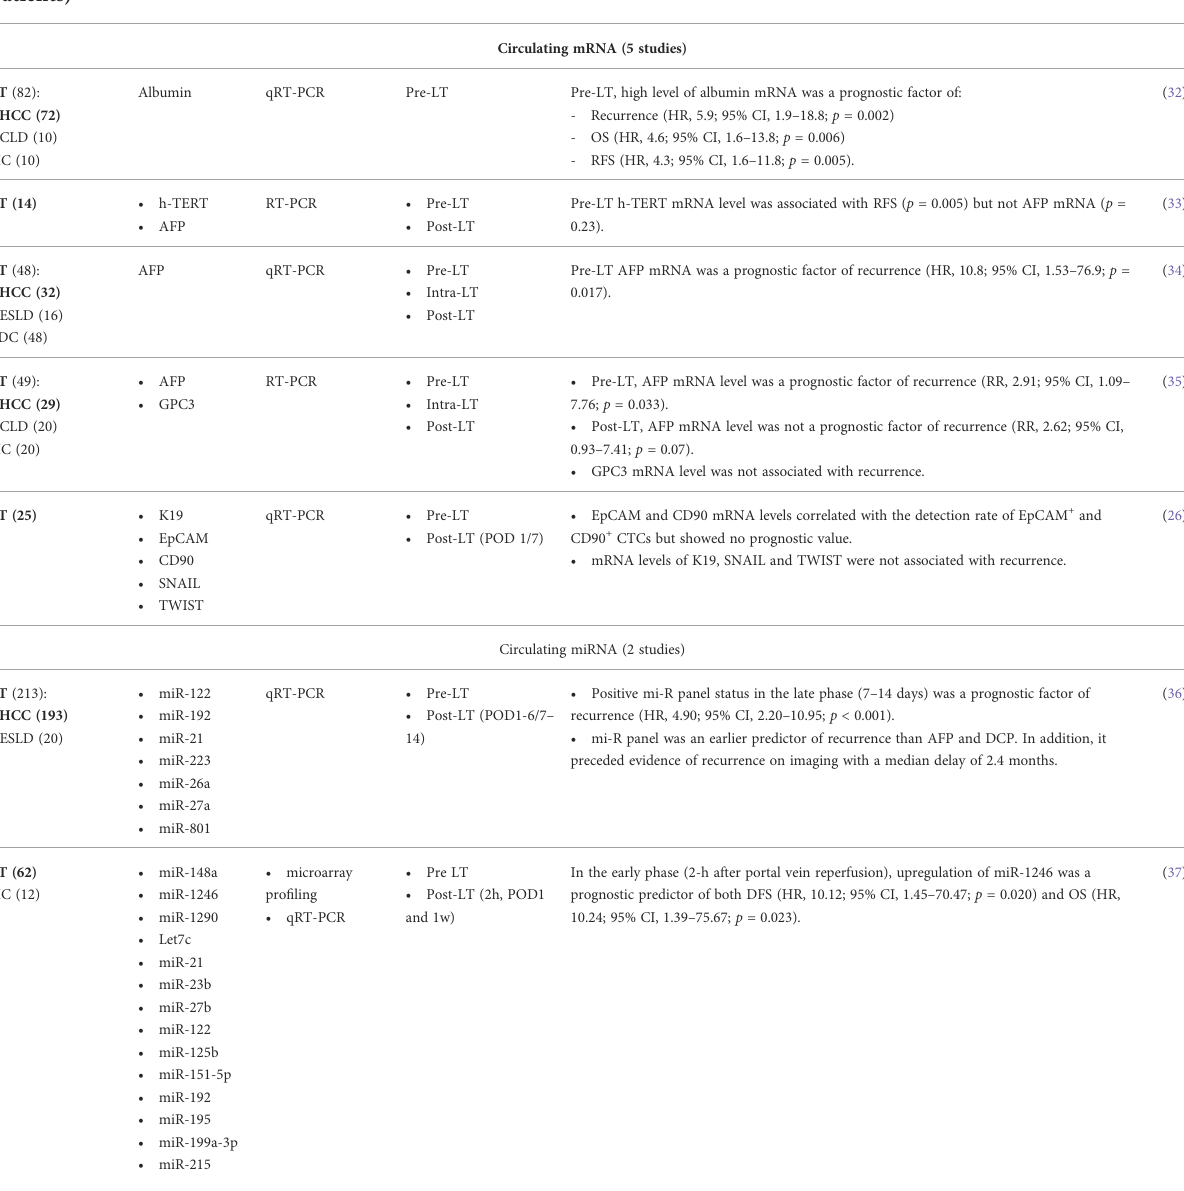
TABLE 2 Circulating mRNAs and miRNAs in liver transplantation for hepatocellular carcinoma. Treatment (Number of